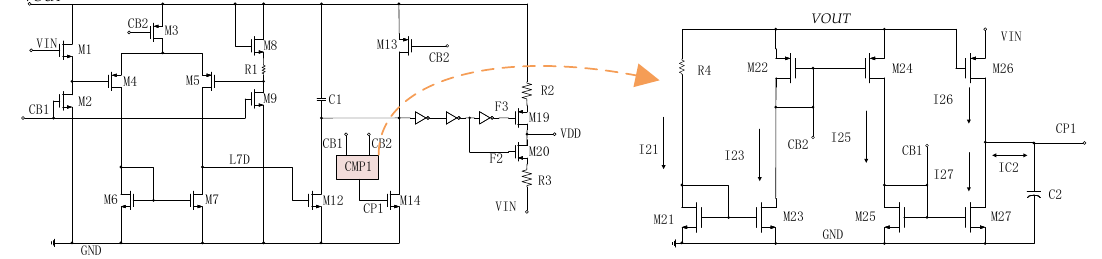
Figure 3. Circuit structure diagram of